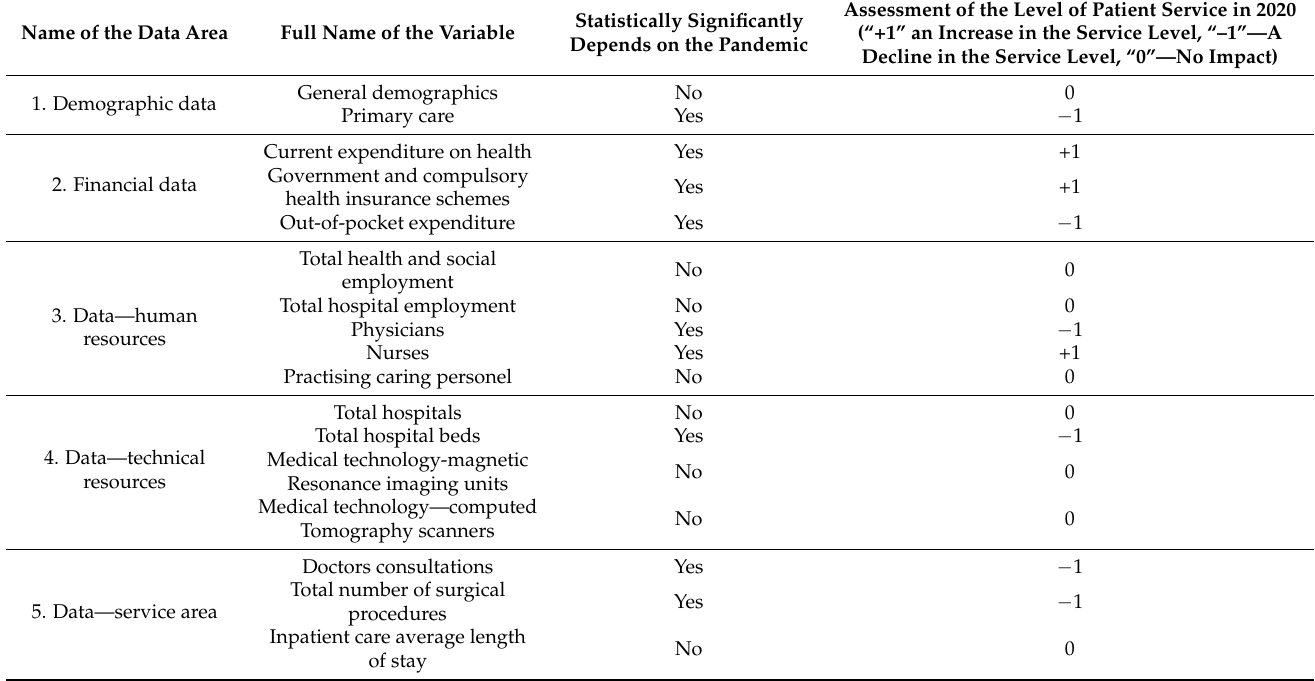
Table 13. Indicators of the level of patient service during the